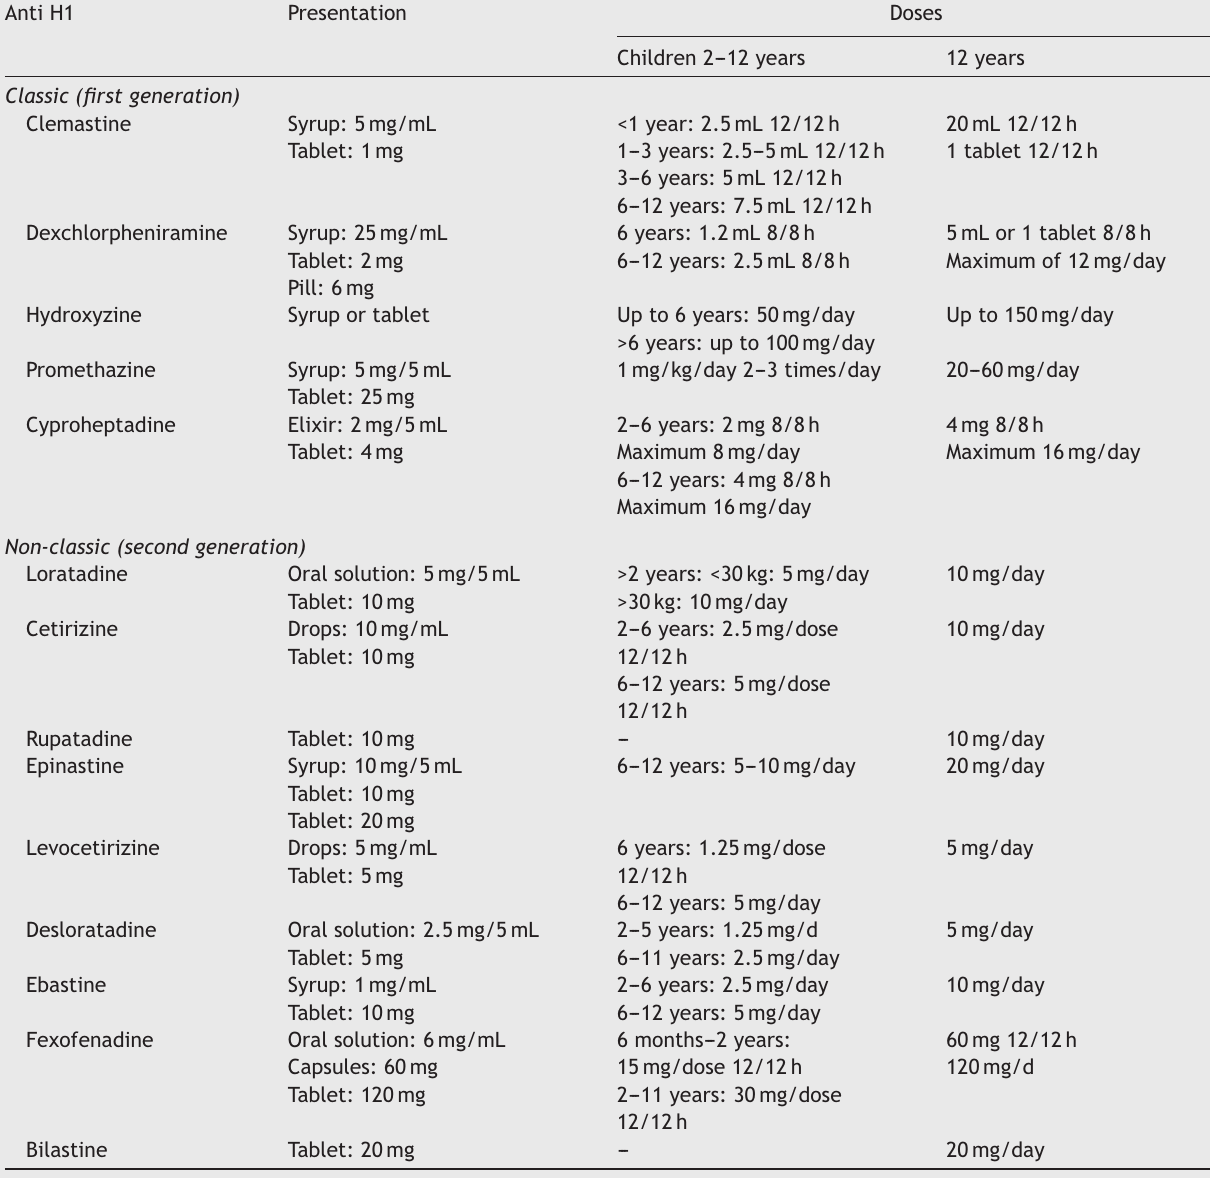
Antihistamine presentation and